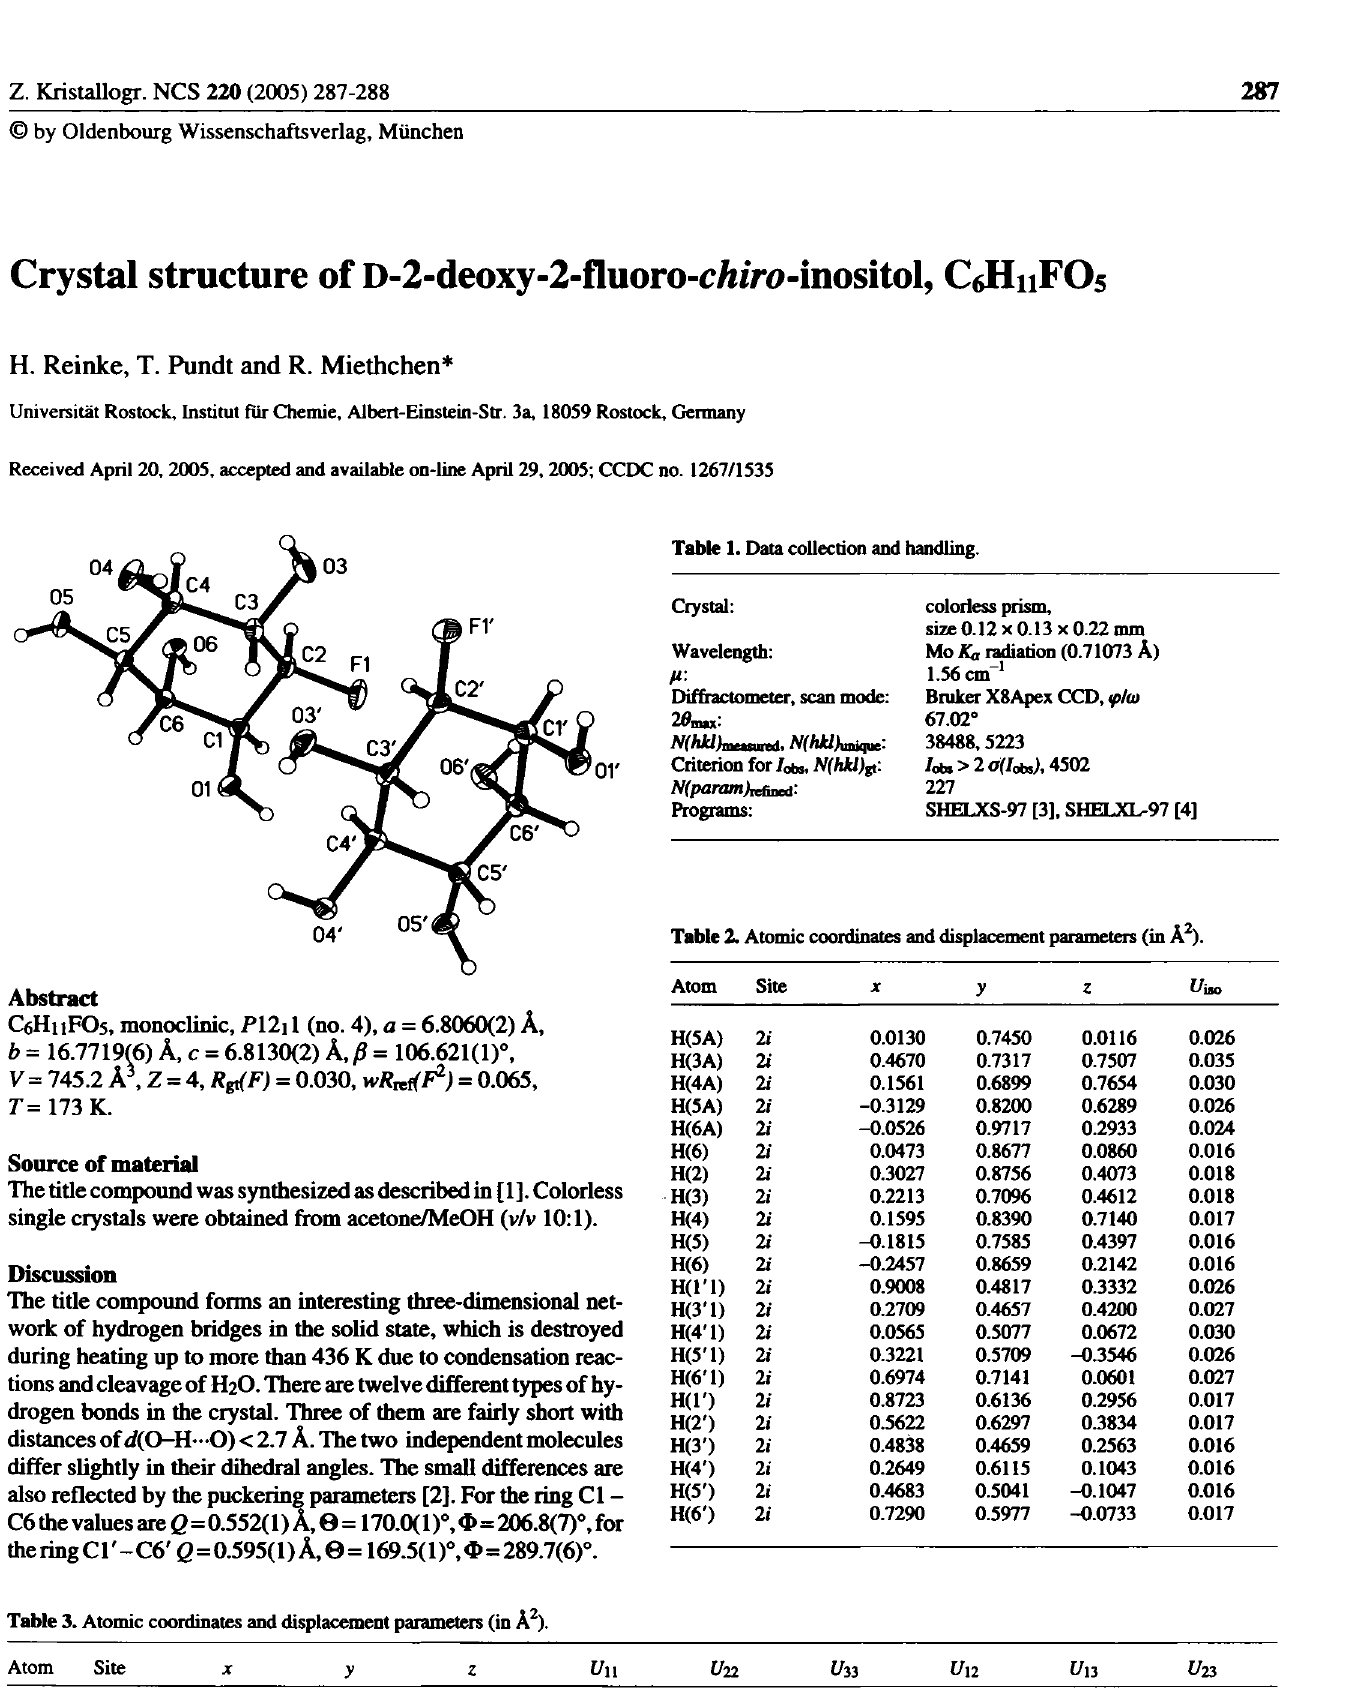
Table 3. Atomic coordinates and displacement parameters (in Ä 2